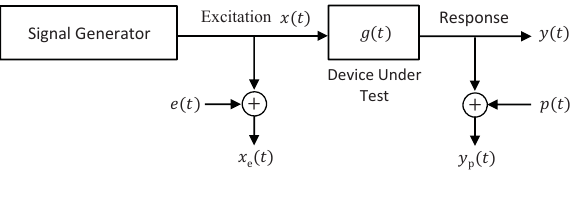
Figure 1: Typical measurement